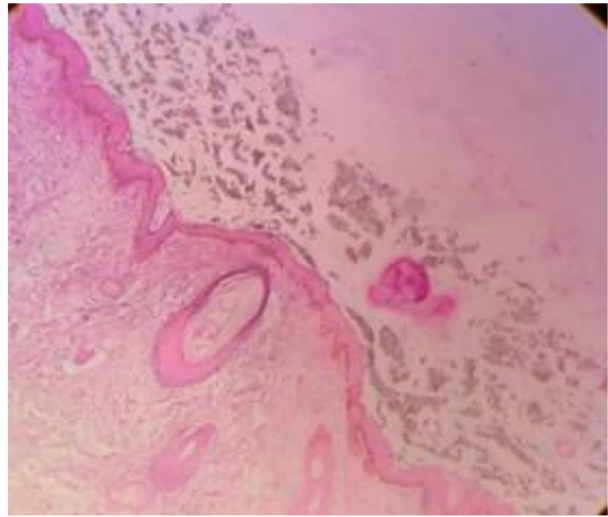
Fig. 3. Photomicrograph of skin section inked with nail enamel showing band appearance.